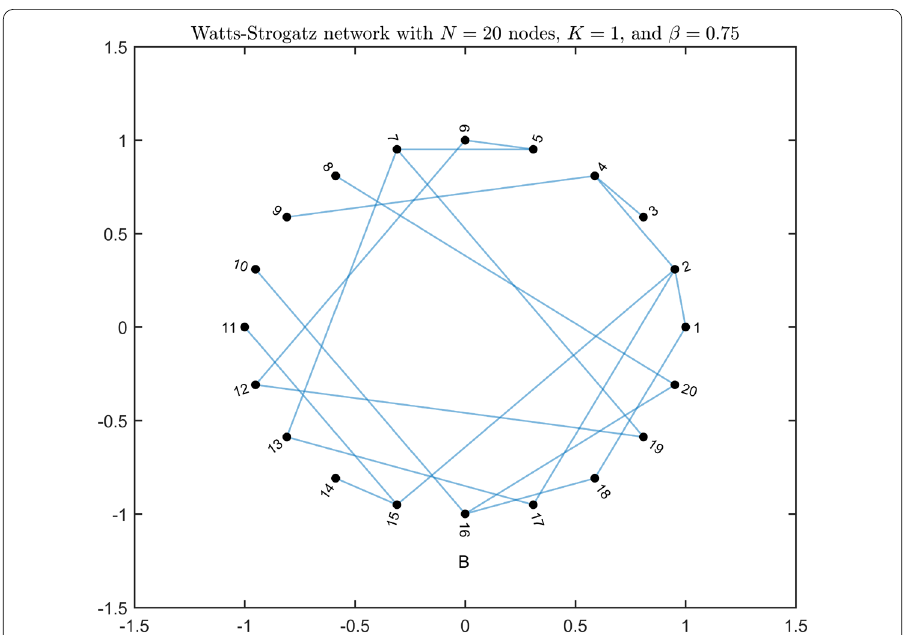
Figure 14 The topology structure of Watts-Strogatz complex network with N = 20, K = 1 and β = 0.75.